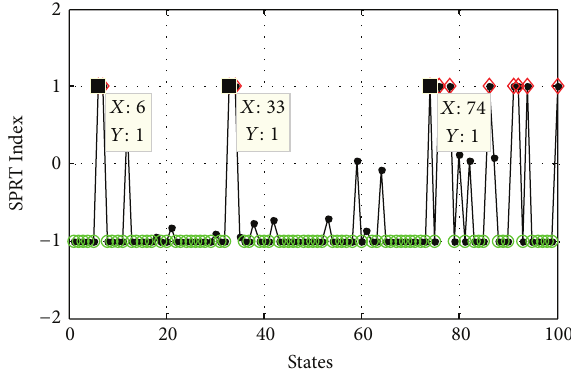
Figure 16: Result of AMM.